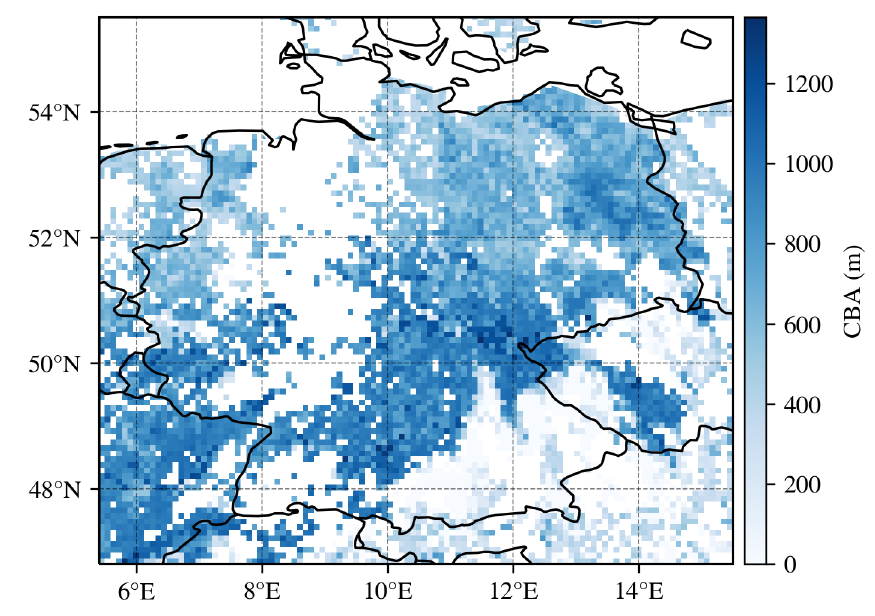
Figure 1. Example scene of cloud base height predicted by the HYFOG algorithm for 15 Junuary 2015 06:00